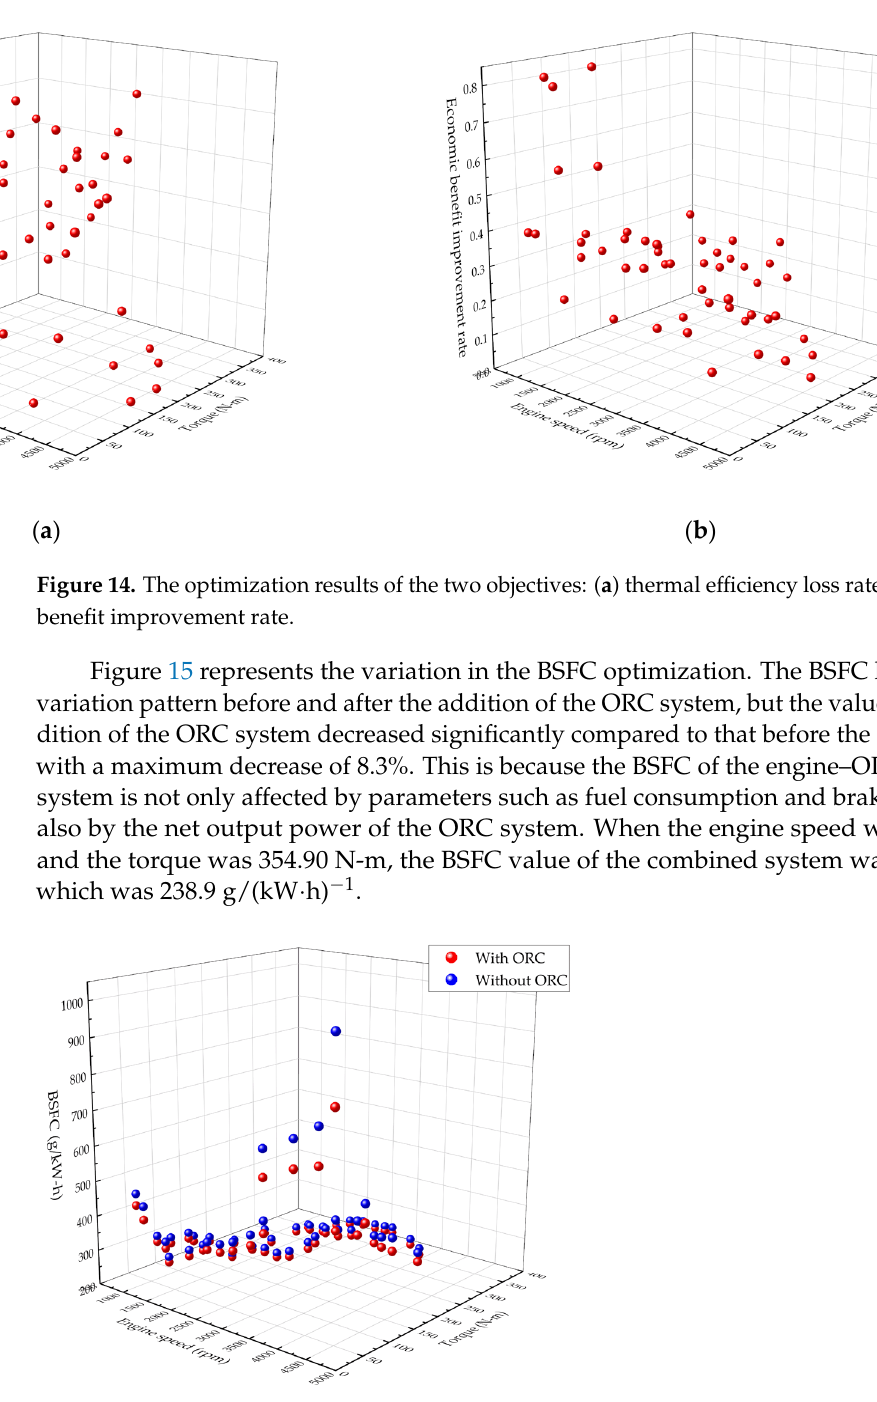
Figure 15. The comparison of BSFC with ORC.